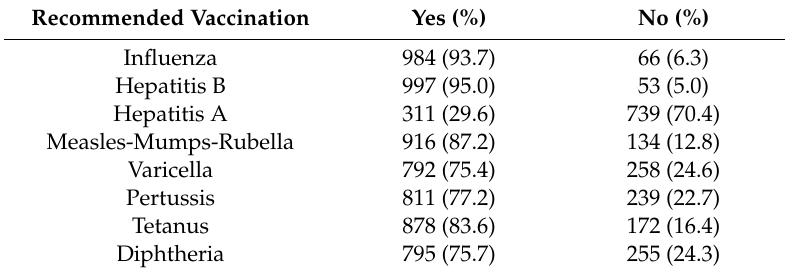
Table 2. Correct responses of 1050 PHPs regarding the recommended vaccinations for healthcare workers